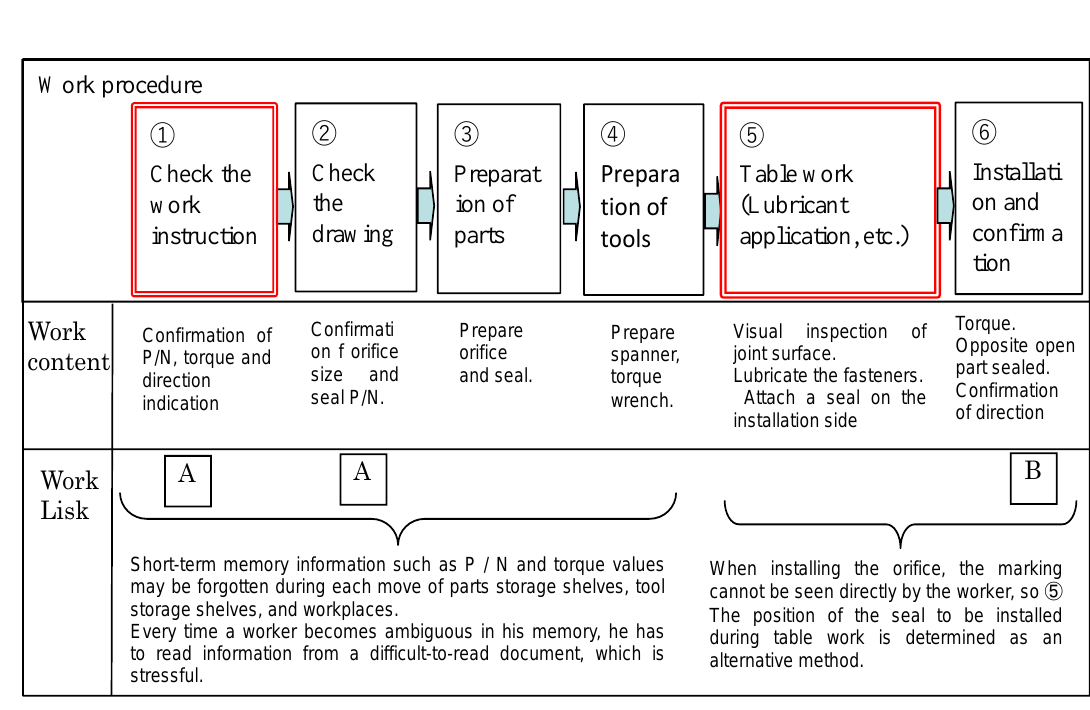
Figure 8. Work risks of skilled workers in orifice installation